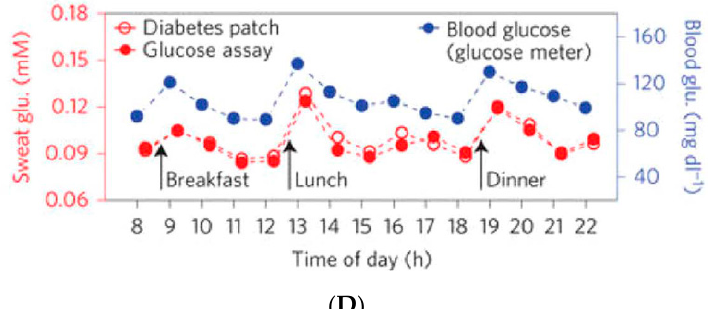
Figure 10. ( A , B ) Flexible patch and its transfer on skin. ( C ) Sweat generation with the wearable patch on the subject’s arm. Reproduced from [40]. Copyright © 2017, The Authors. Creative Commons Attribution-NonCommercial license. ( D ) Comparison between the patch, a glucose strip, and continuous glucose monitoring (CGM) over the course of a day. Reproduced from [41] with permission. Copyright © 2016, Springer Nature.